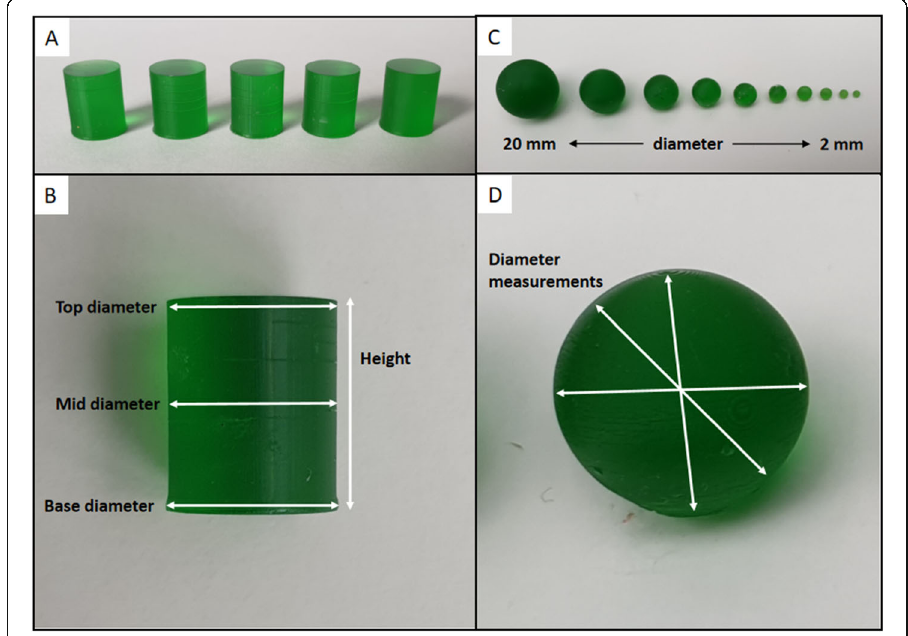
Fig. 2 Example of 5 out of the 20 printed cylinders ( a ) and the dimensions that were measured on each cylinder ( b ). The printed spheres had nominal diameters of 20, 15, 12, 10, 8, 6, 5, 4, 3 and 2 mm ( c ) which were measured after printing at multiple orientations ( d